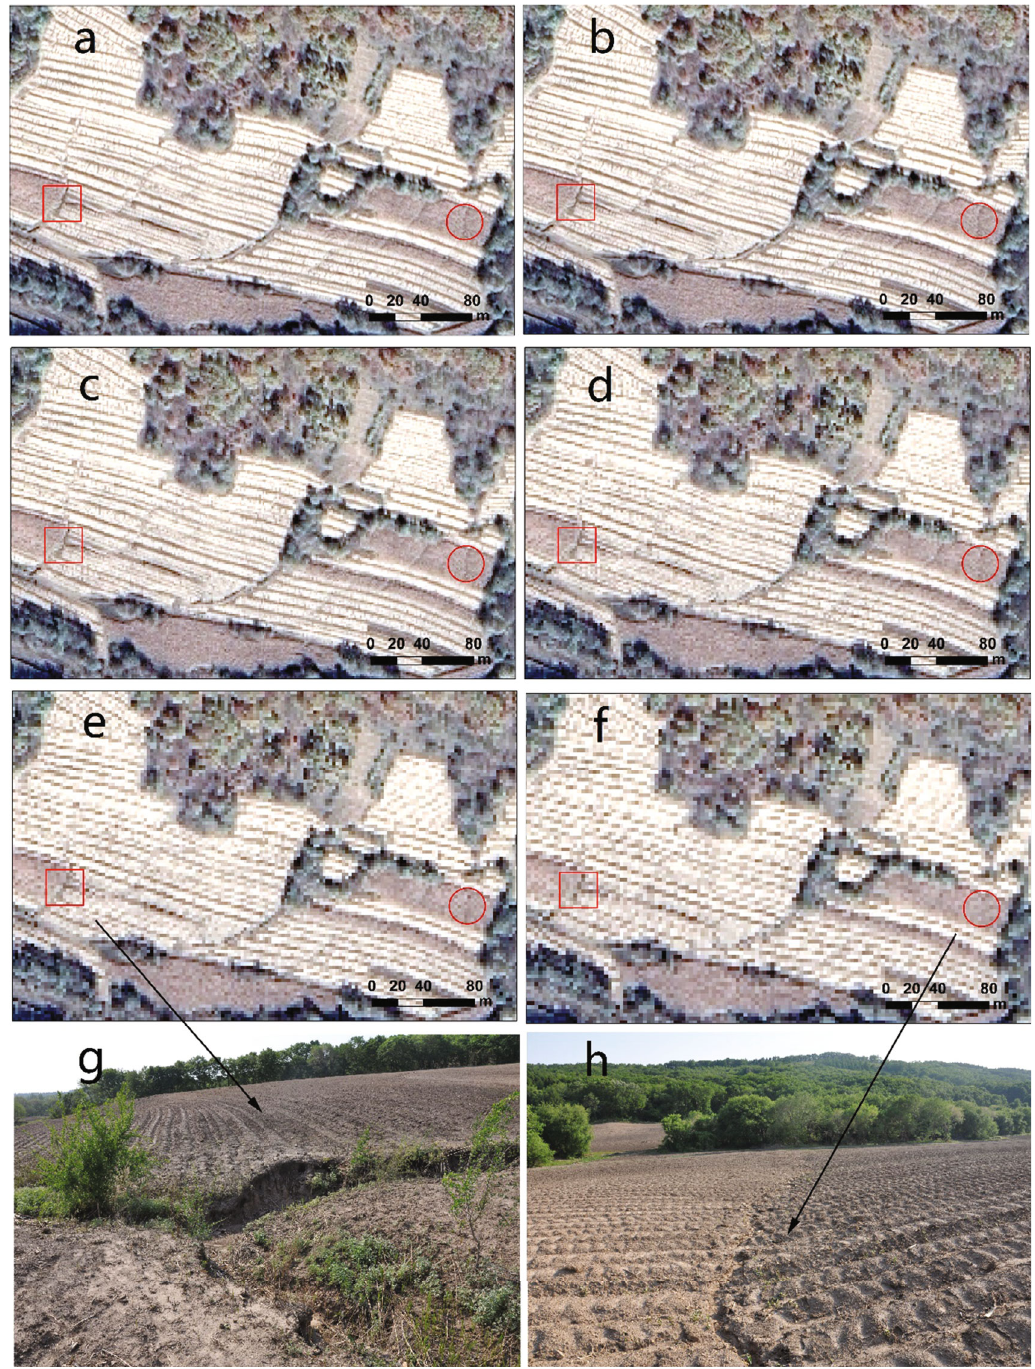
Figure 5: Image characteristics of the permanent gully and ephemeral gully on Pleiades images with di ff erent resolutions ((a) 0.7m, (b) 1 m, (c) 1.5m, (d) 2 m, (e) 2.5m, (f) 3 M, and (g, h) photos of the gullies at